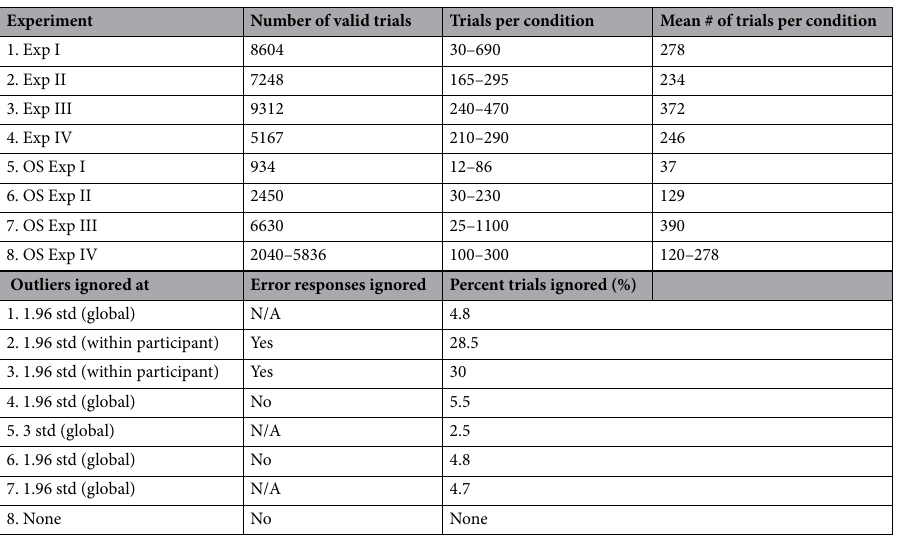
Table 2. Main differences in the data analysis for the eight